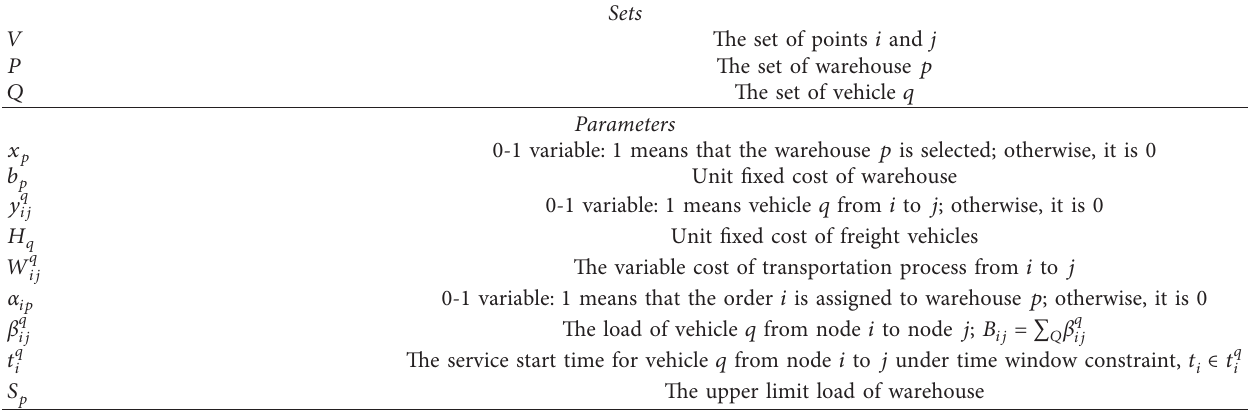
Table 1: Variables’ descriptions.